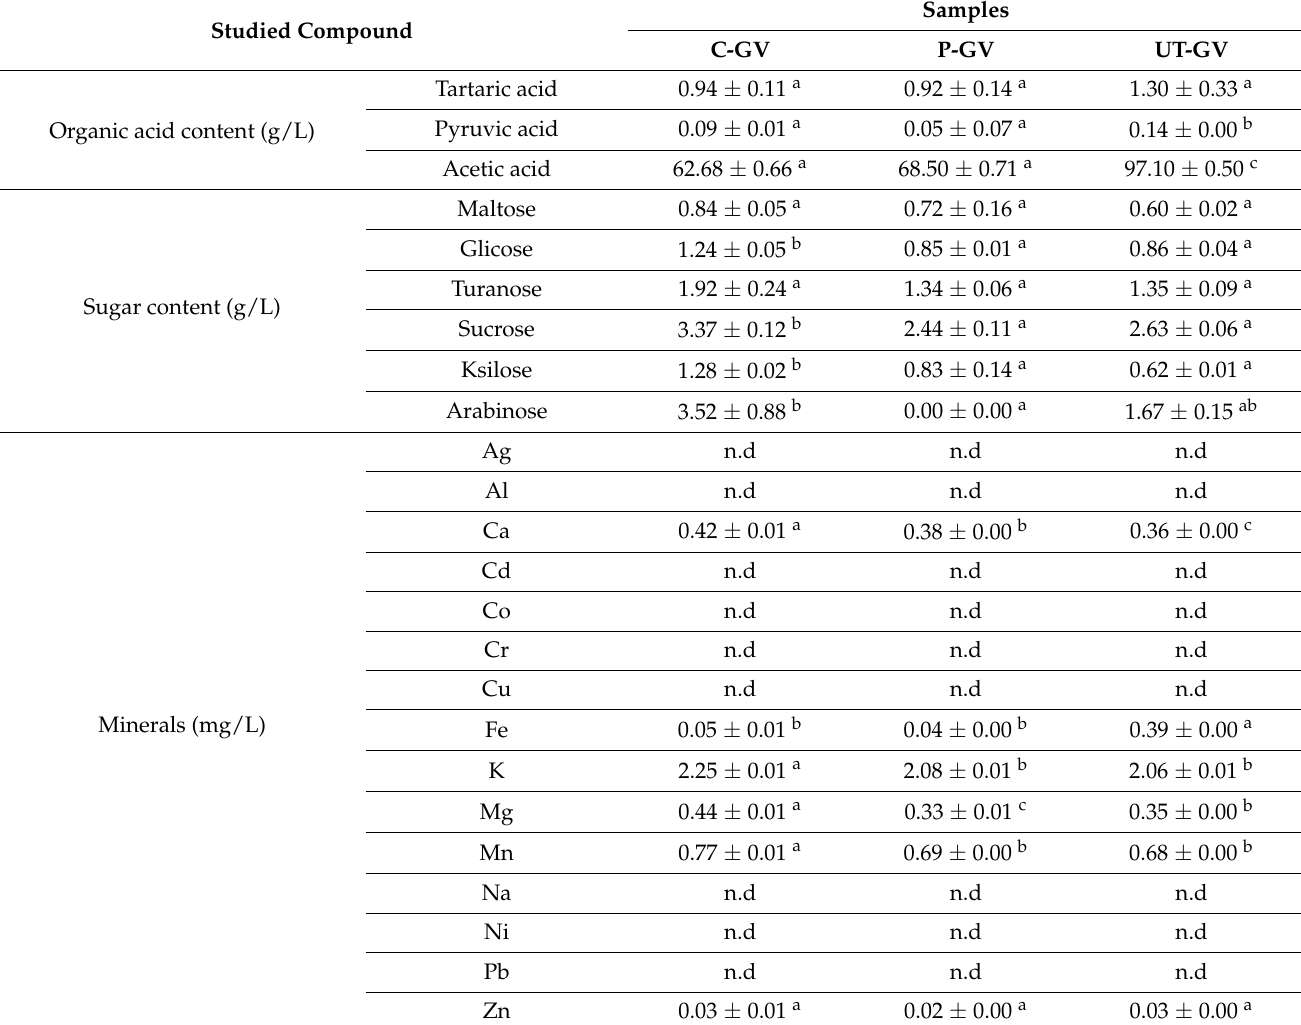
Table 6. Organic acid, sugar, and mineral element analysis results of C-GV, P-GV, and